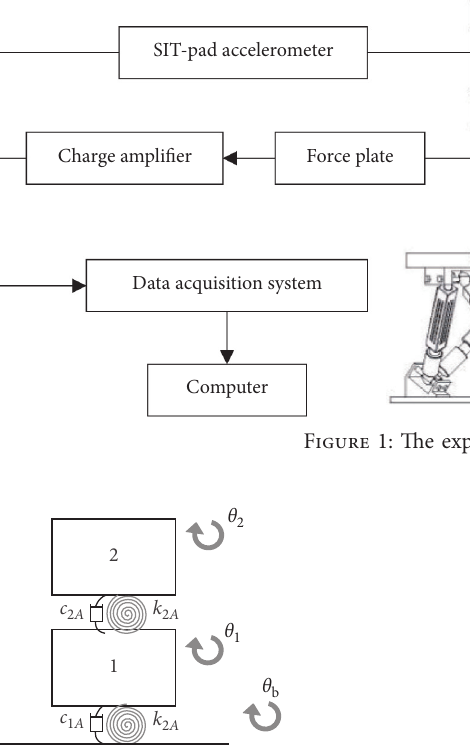
Figure 2: The roll response model with roll excitation. Figure 3: The roll response model with lateral